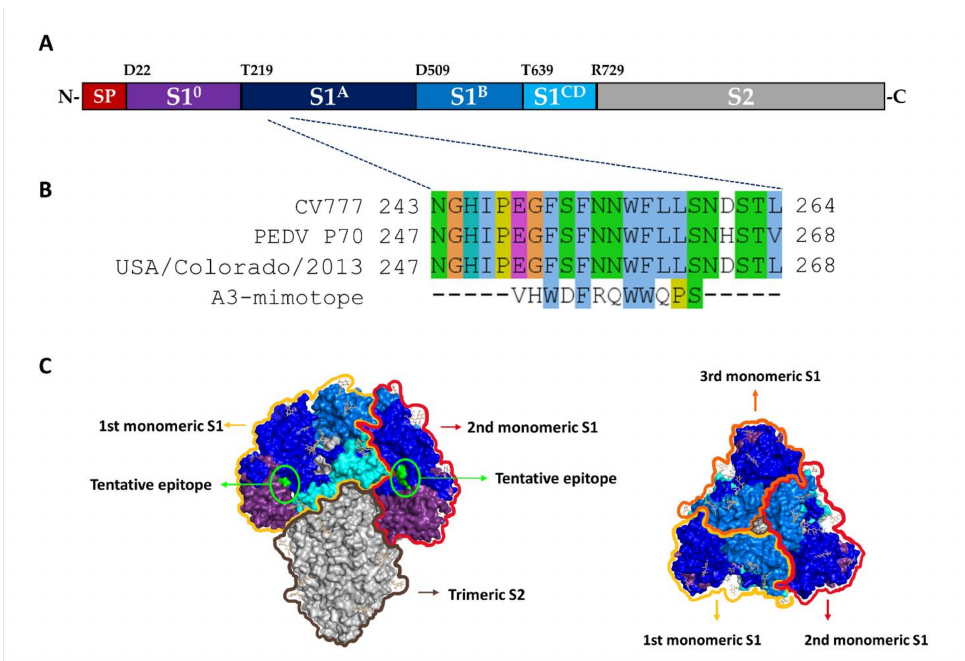
Figure 6. Presumptive amino acid sequence that was bound by mAbA3 as determined by phage mimotope identification using Ph.D. TM -12 Phage display peptide library. ( A ) Domain organization of spike protein of PEDV P70 strain (adapted from [25]). S1 portion can be divided into 4 subdomains including S1 0 (purple); S1A (dark blue); S1B (marine); and S1C and D (cyan). ( B ) Amino acid sequence of phage mimotope that was bound by mAbA3 (A3-mimotope). Multiple sequence alignment of A3-mimotope with S1 segments of CV777 classical strain (GenBank: AEX92968.1), PEDV P70 (strain of this study) and USA/Colorado/2013 (GenBank: AGO58924.1; the strain that Cryo-EM structure is available, PDB: 6vv5) revealed that the tentative epitope “252EGFSFNNWFLLS263” is located at the S1A subdomain. Each amino acid was colored by Clustal X scheme, which is based on chemical characteristic of amino acid. ( C ) Illustration of tentative epitope of the mAbA3 (green) on the PEDV spike protein homotrimer: side view (left) and top view (right).